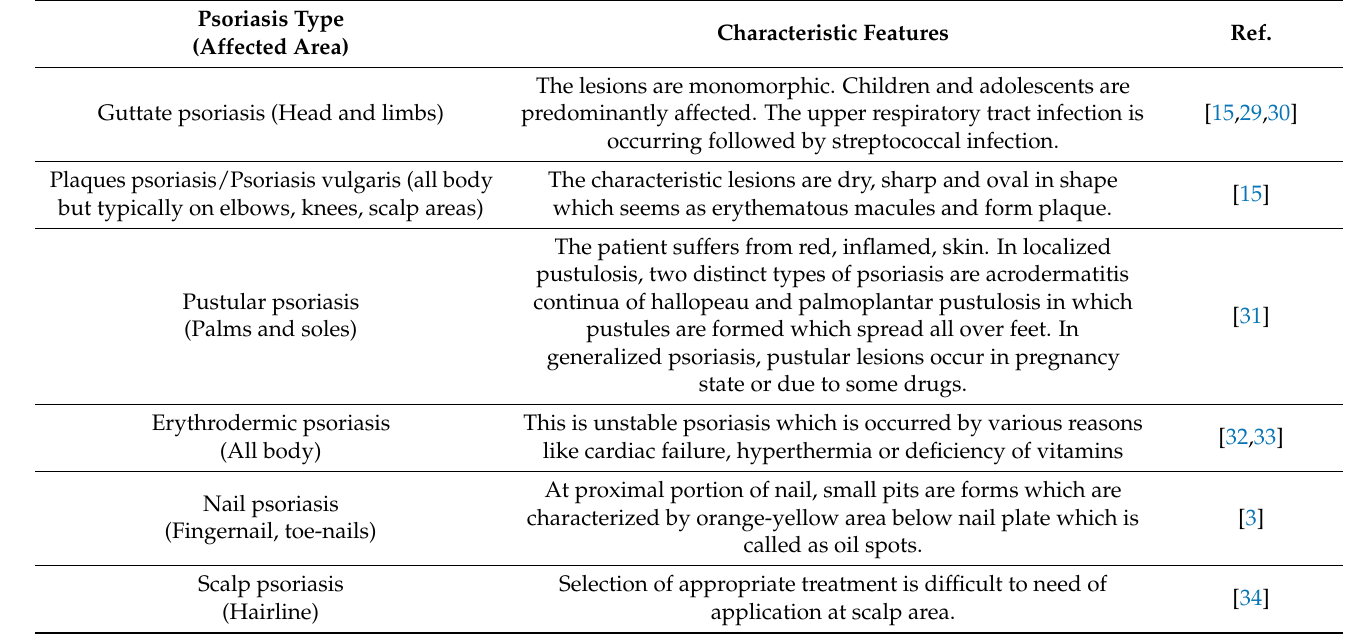
Table 1. Types of psoriasis and their characteristic